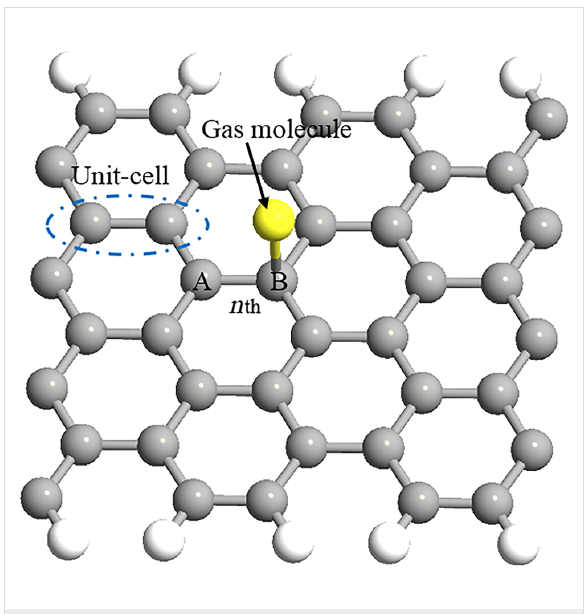
Figure 1: Illustration of the gas molecule adsorption on the armchair graphene nanoribbon (AGNR) unit